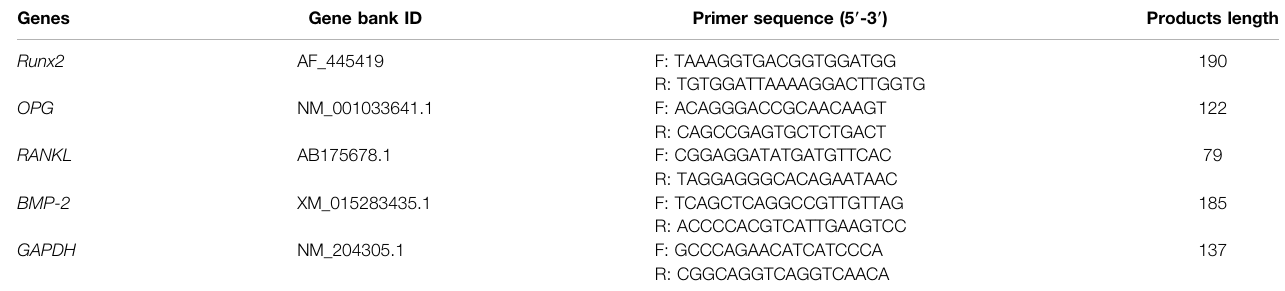
TABLE 1 | Primers used for the quantitative polymerase chain reaction.